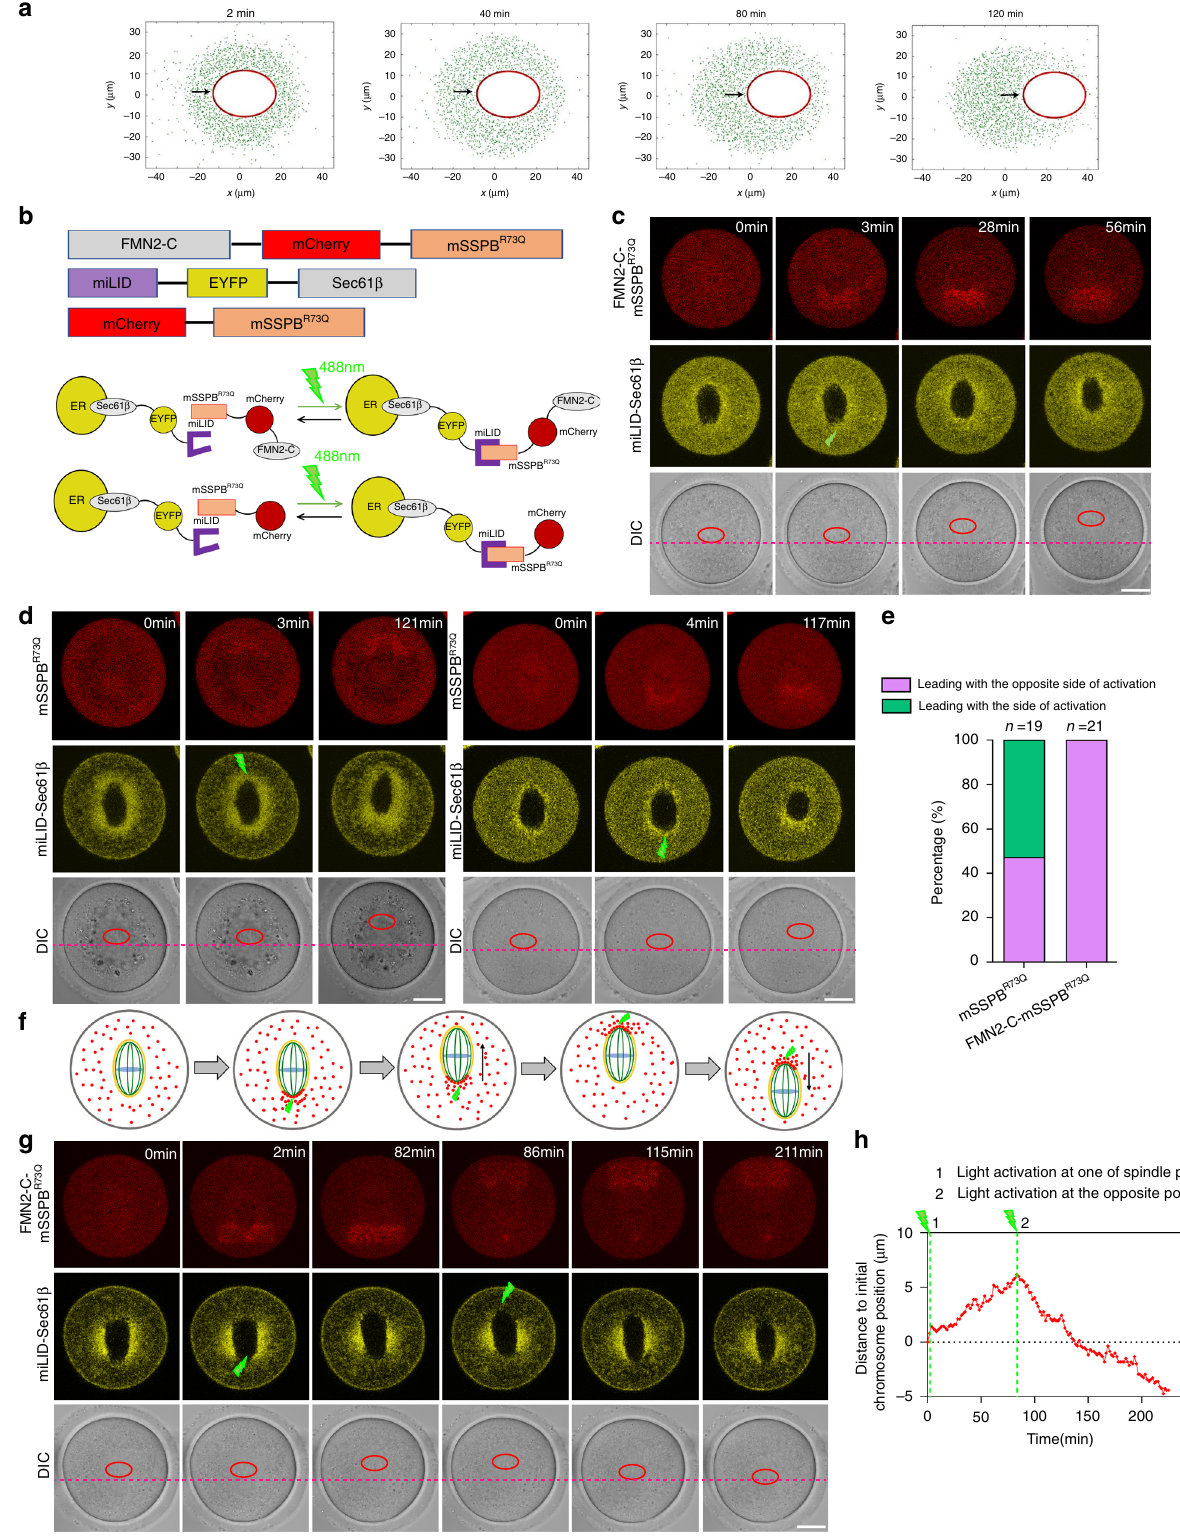
Immunoblotting and antibodies . For immunoblot analysis, a total of 50 oocytes of each group were placed in Laemmli sample buffer (SDS sample buffer and 2- Mercaptoethanol) and boiled at 100 °C for 5min. The samples were loaded